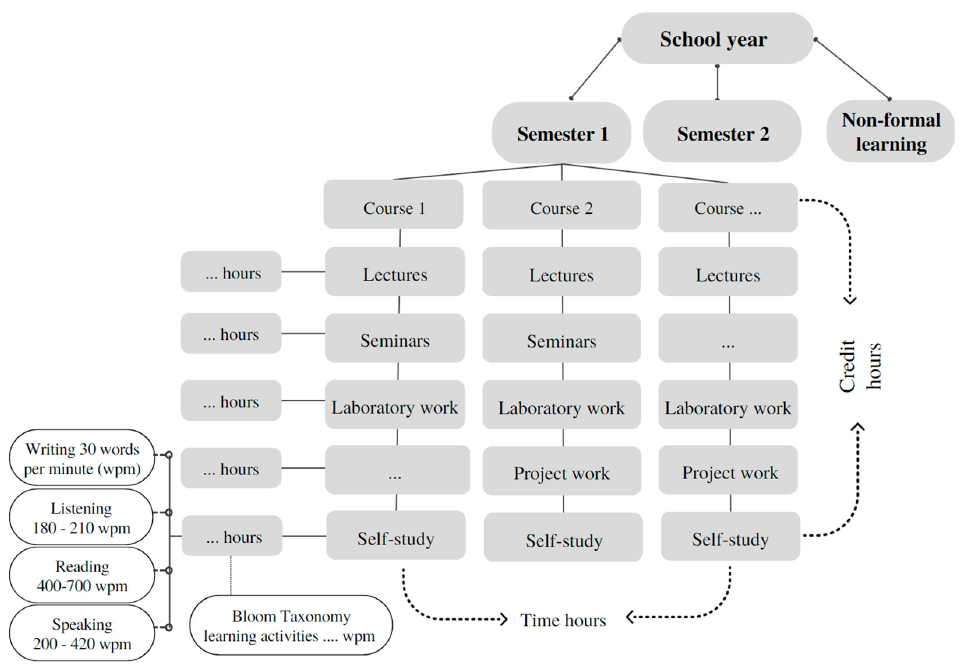
Figure 1. School year—Credit hours and Time hours map.